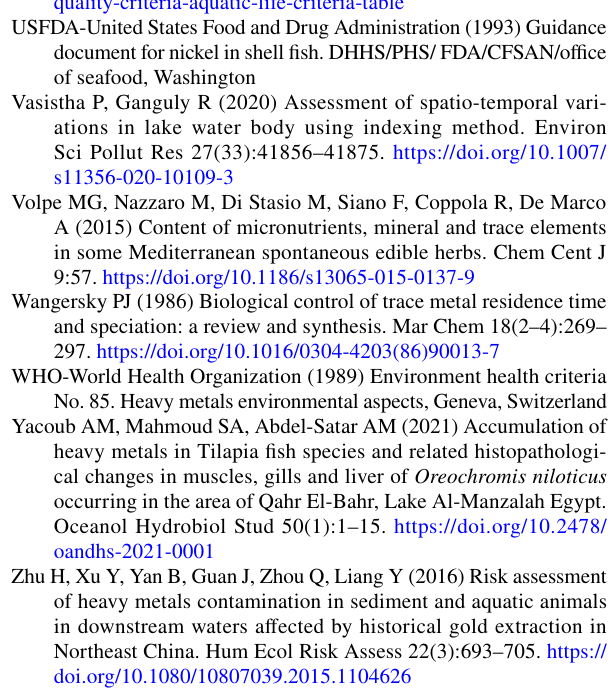
table. https:// www. epa. gov/ wqc/ natio nalre comme nded- water- quali ty- crite ria- aquat ic- life- crite ria- table USFDA-United States Food and Drug Administration (1993) Guidance document for nickel in shell fish. DHHS/PHS/